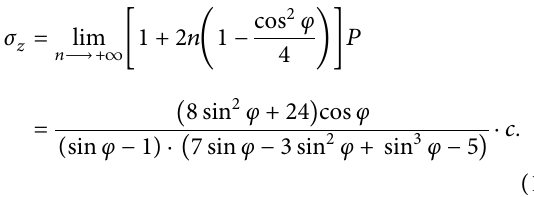
Figure 5: The stress field constructed by numerous stress columns.